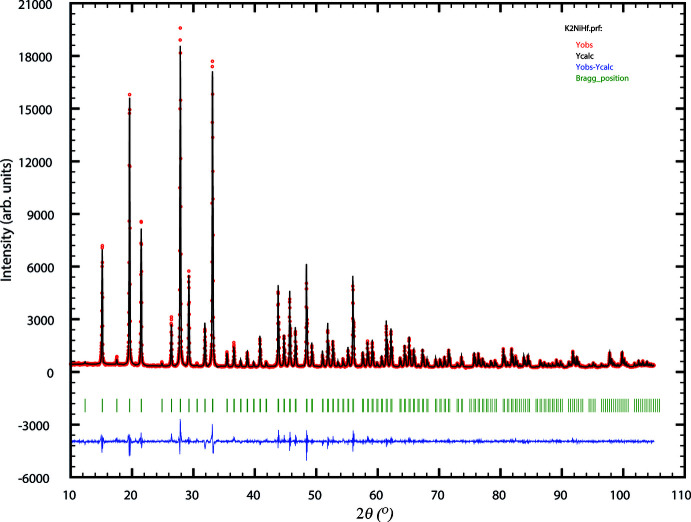
Rietveld refinement of K2Ni0.5Hf1.5(PO4)3. Experimental (dots), calculated (red curve) and difference (blue curve) data for 2θ range 10–108°.